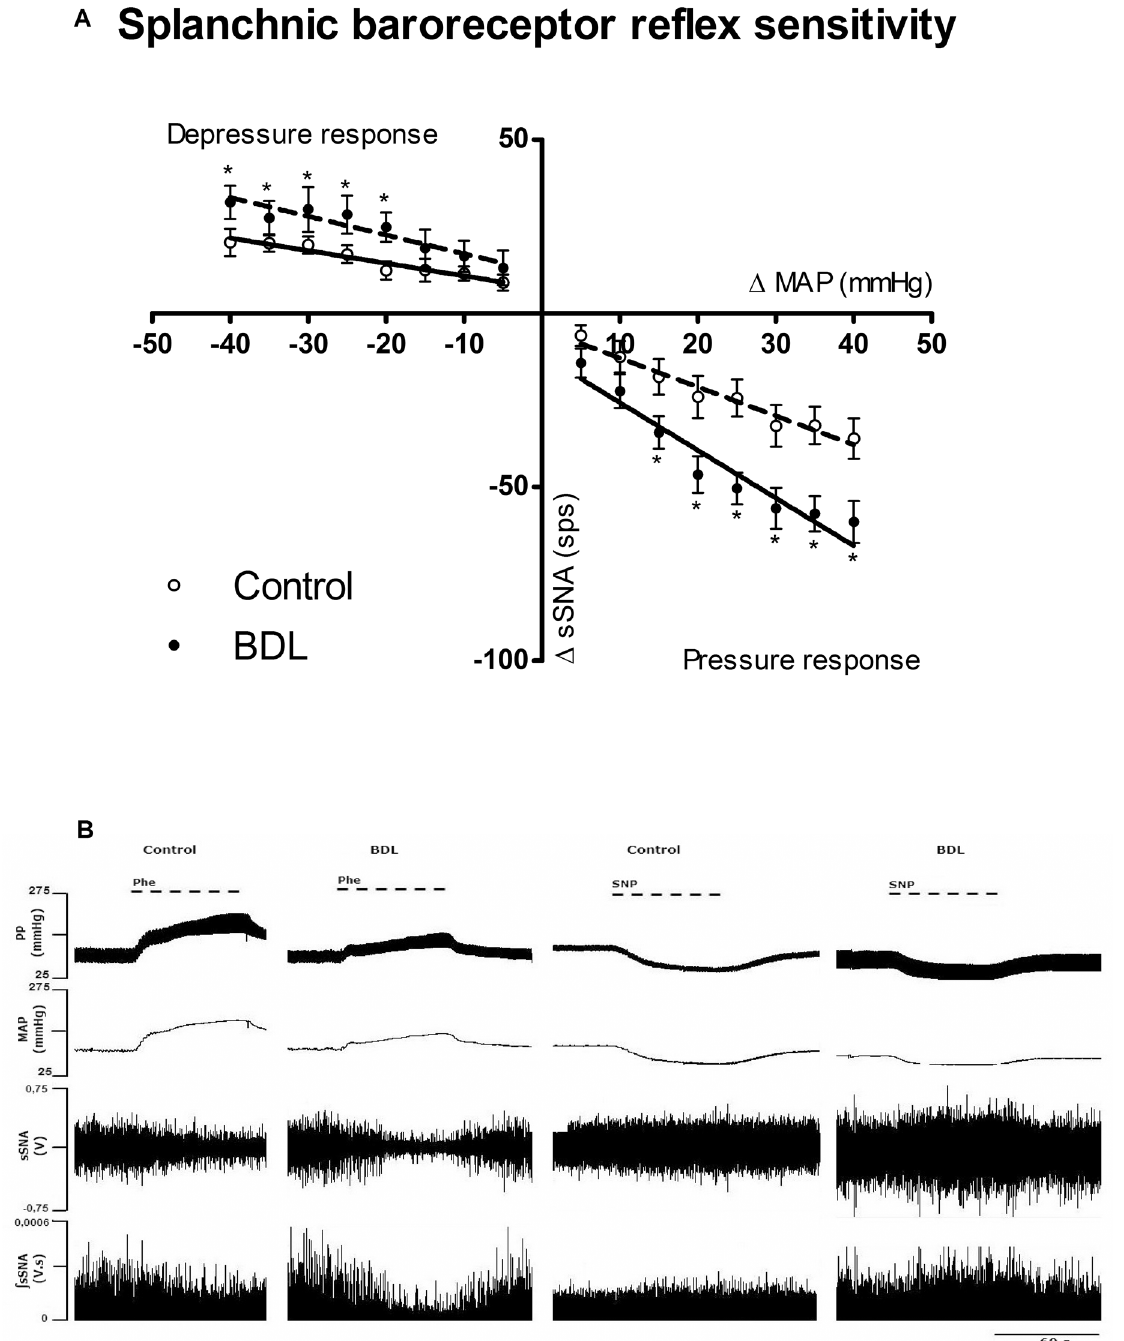
Fig 3. Baroreceptor reflex sensitivity for splanchnic sympathetic nerve activity (sSNA). ( A ) Linear regression graph showing: depressor response — the reflexive increase in sSNA to decrease the mean arterial pressure (MAP) produced by ramp infusion of sodium nitroprusside (200 μ g/ml, 6ml/h, iv); and pressor response — sSNA decrease reflex response to increase MAP produced by ramp infusion of phenylephrine (100 μ g/ml, 6ml/h, iv) for 60s in the control and bile duction ligation (BDL) groups. n, number of rats * P < 0.05 compared to control group (Sutdent ’ t test). ( B ) Representative recording cardiovascular responses induced by ramp infusion of phenylephrine (Phe) and sodium nitroprusside (SNP) in the control and BDL groups. Pulse pressure (PP), mean arterial pressure (MAP), sSNA expressed in volts (V) and integrated ( ʃ ) sSNA expressed in volts-seconds (V.s).